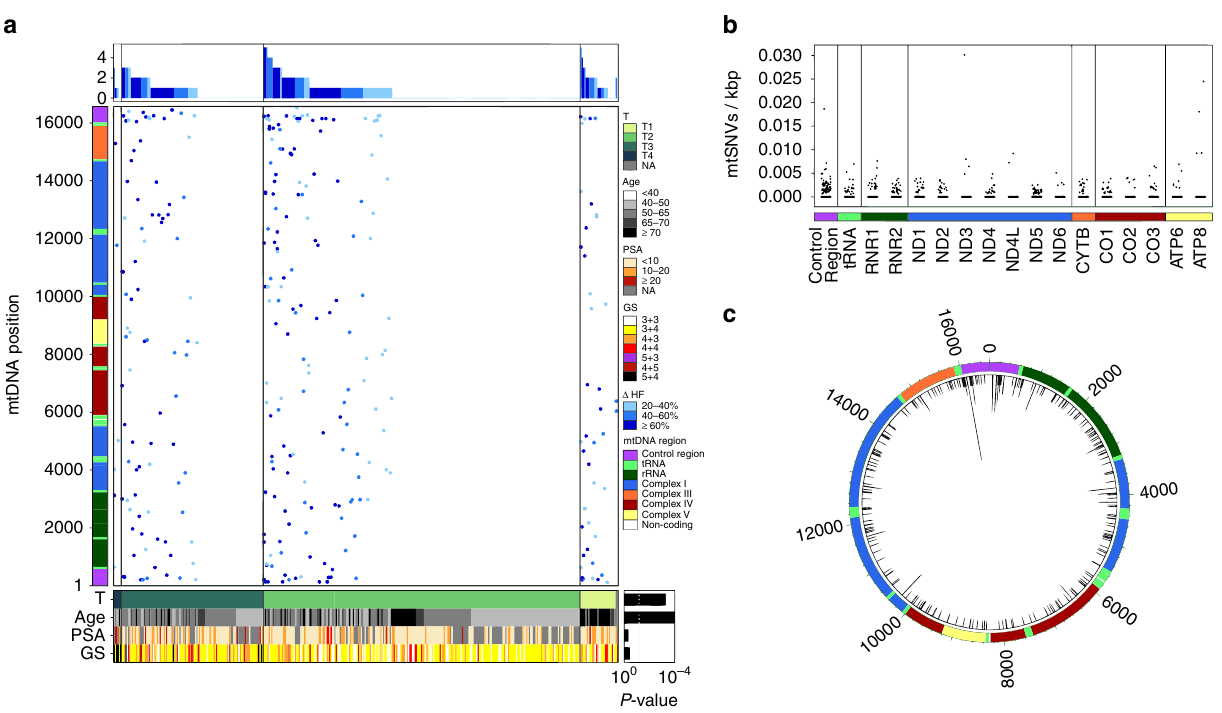
Fig. 1 Panorama of mitochondrial mutations in prostate cancer. a The top panel displays the number of mtSNVs per patient sorted fi rst by T-Category and then by the number of mtSNVs; histogram bars are colored by the average difference in the heteroplasmy fraction ( Δ HF ) between tumor and normal samples, light-blue 20 – 40%, medium-blue 40 – 60%, dark-blue ≥ 60%. A heatmap showing the location of each mtSNV on the mitochondrial genome ( middle ), where the color of each dot represents Δ HF. The mitochondrial genome is represented on the left . The bottom panel shows the clinical covariates for all 384 patients: Age, Gleason Score, PSA, and T-Category. Bottom right : Associations between the covariates and number of mtSNVs. b Frequency and distribution of single-nucleotide variants ( SNVs ) within the mitochondrial genome. Mutation frequency normalized by dividing the number of mutations per locus of each patient by (length of the locus (kbp) × MCN). c Distribution of mtSNVs across the mitochondrial genome. mtSNVs were fairly evenly distributed across the genome ( black bars ) and recurrent mutation positions are indicated by the